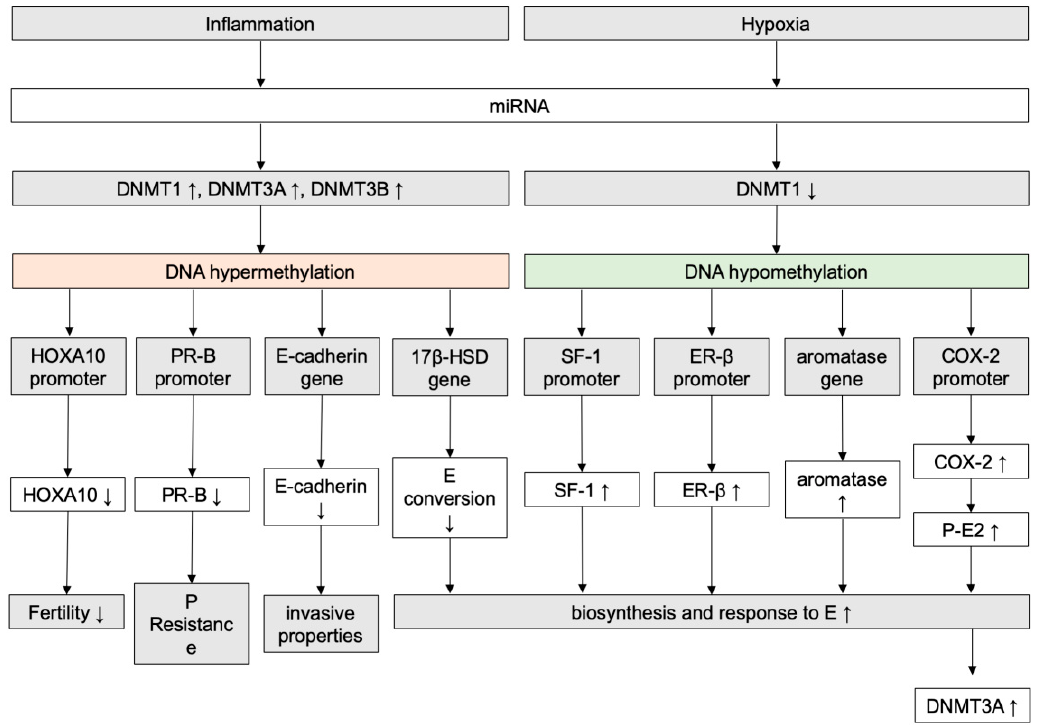
Figure 3. Epigenetic mechanisms of hypermethylation and hypomethylation involved in the etiopathogenesis of endometriosis. Hypoxia and inflammation regulate DNA methylation through microRNAs (miRNA), and genes coding for three DNA methyltransferases (DNMT) were reported overexpressed in endometriosis. microRNAs (miRNA); DNA methyltransferases (DNMT); Homeobox A transcription factor (HOXA10); Progesterone receptor B (PR-B); 17 β -hydroxysteroid dehydrogenase (17 β -HSD); Steroidogenic factor-1 (SF-1); Estrogen receptor β (ER- β ); Cyclo-oxygenase type 2 (COX-2); Prostaglandin E2 (P-E2); Estrogen (E); Progesterone (P).